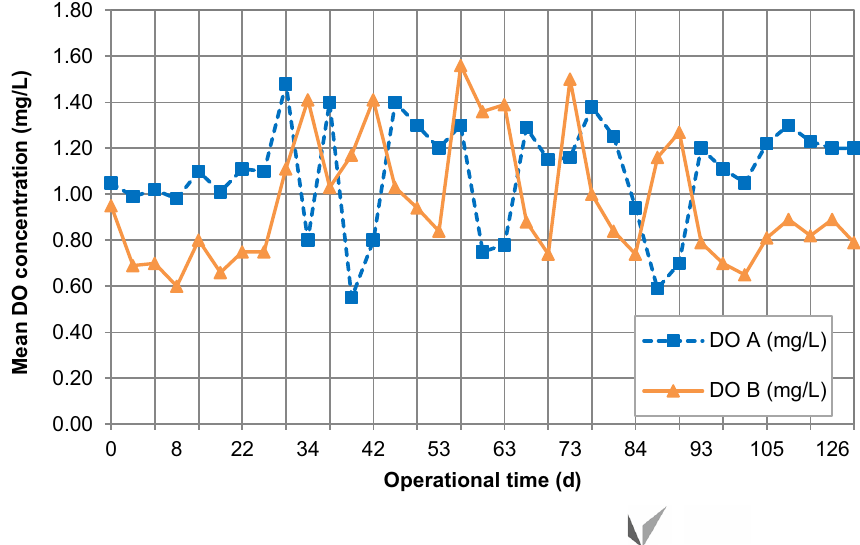
Fig. 1 Profile of dissolved oxygen (DO) concentration for SBR A and SBR B